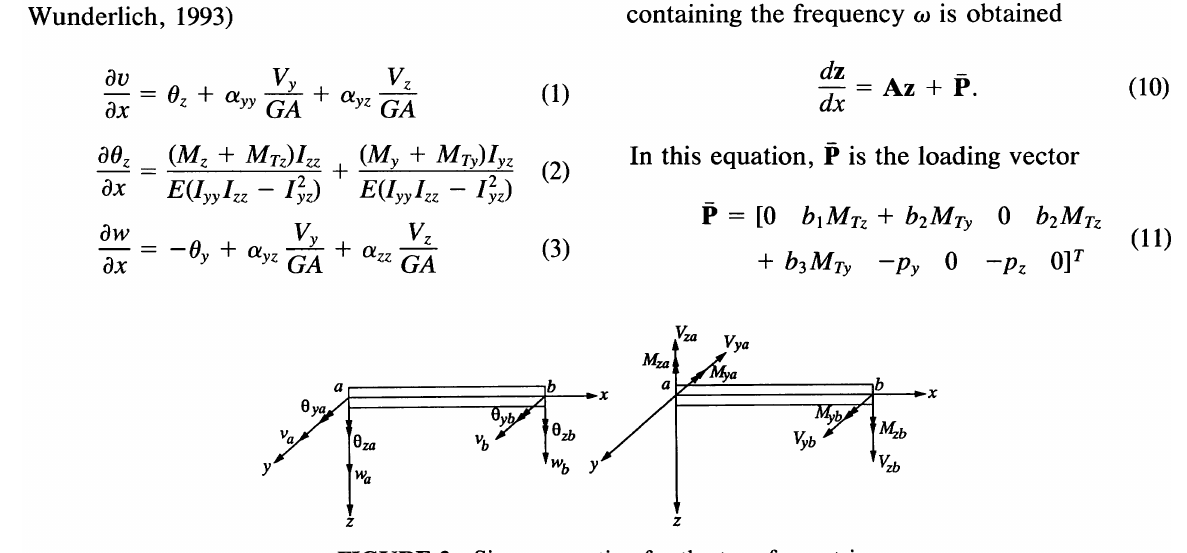
FIGURE 2 Sign convention for the transfer